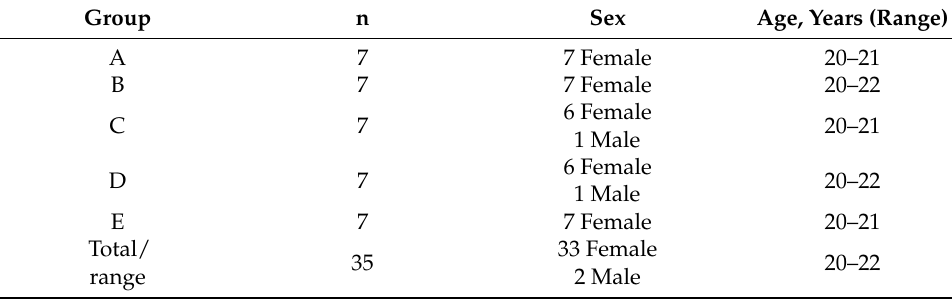
Table 1. Demographic characteristics for nursing